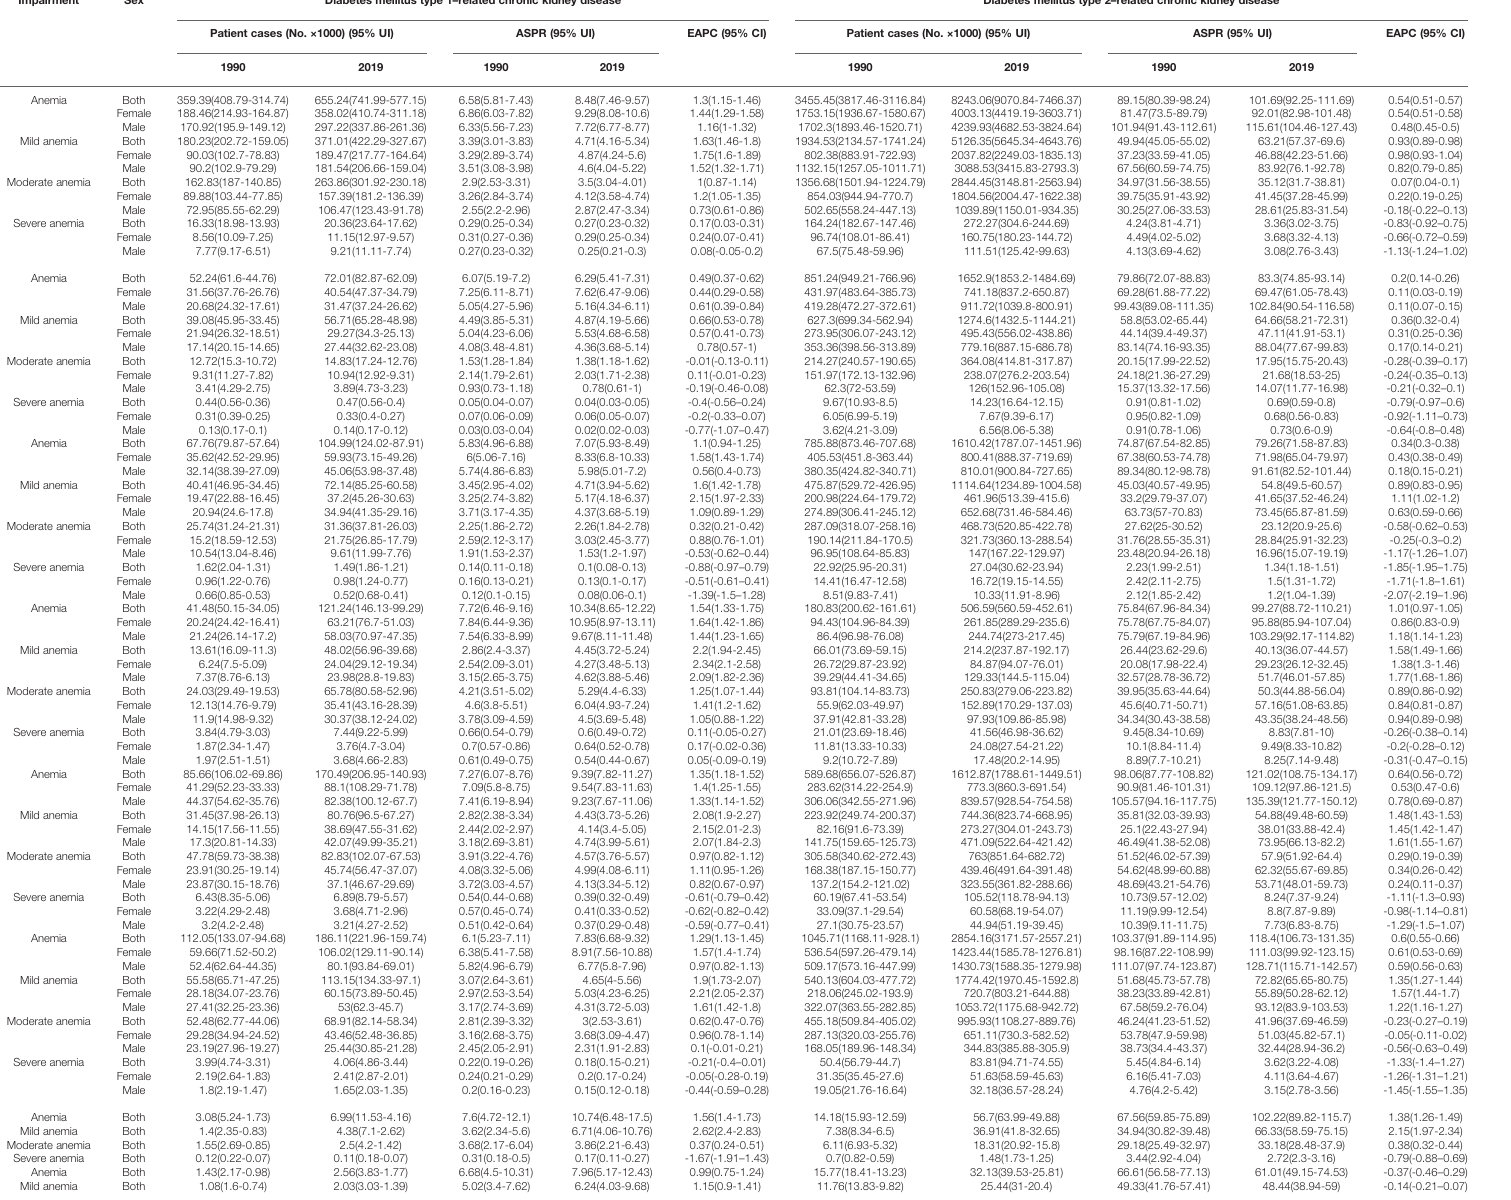
TABLE 3 | The prevalent cases and ASPR of impairment caused by diabetes mellitus – related chronic kidney disease.